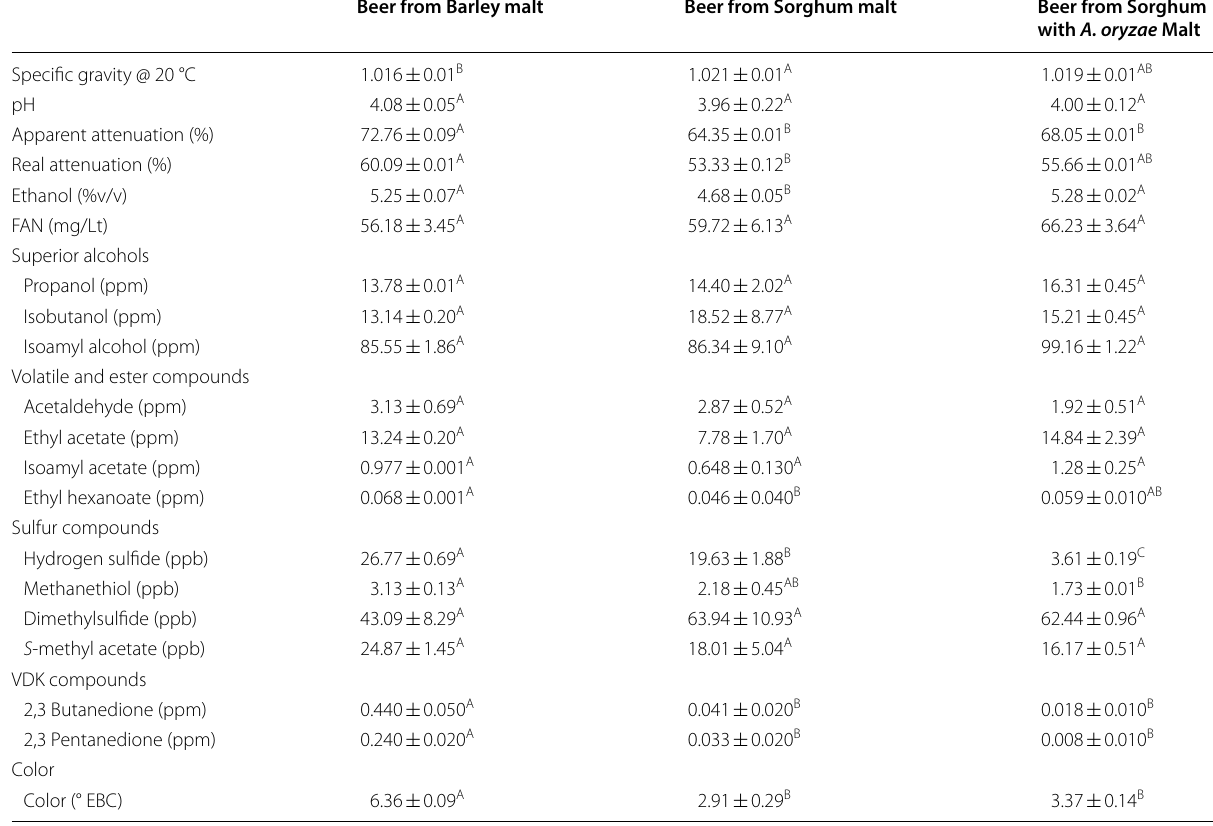
Mean comparisons with different letter(s) within rows are statistically different ( P <